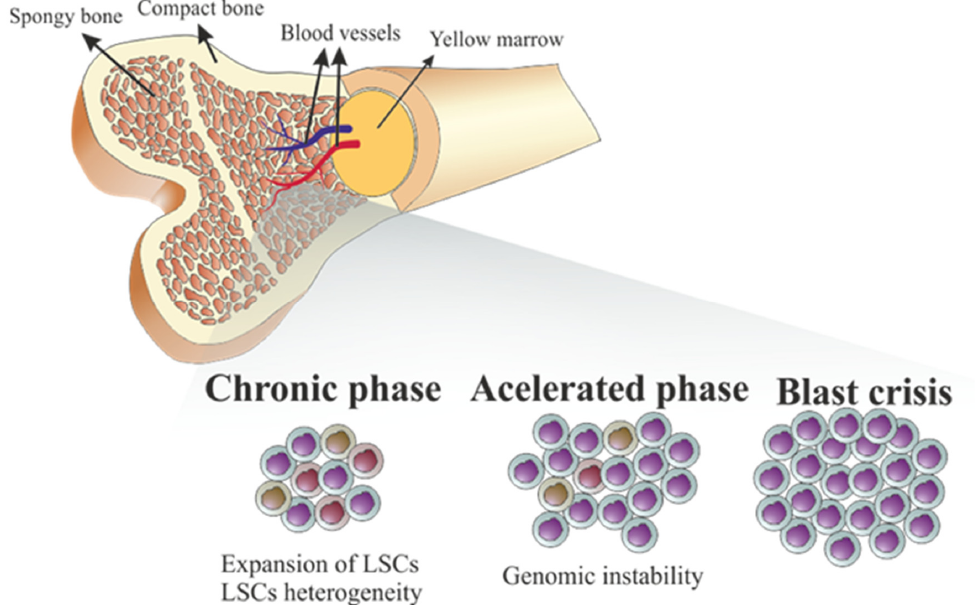
Figure 2. Stages of chronic myeloid leukemia (CML). The continuous activity of BCR-ABL1 protein kinase induces a high proliferation of leukemia stem cells (LSCs) in bone marrow and blood vessels, resulting in a chronic phase. The appearance of resistance to tyrosine kinase inhibitors (TKI), together with a particular bone marrow microenvironment and accumulation of reactive oxygen species (ROS), induce bone marrow genomic instability in quiescent LSCs, that result in an accelerated phase that culminate in a blast crisis with worsening of symptoms. Although the genomic instability due to ROS-induced DNA lesions might occur